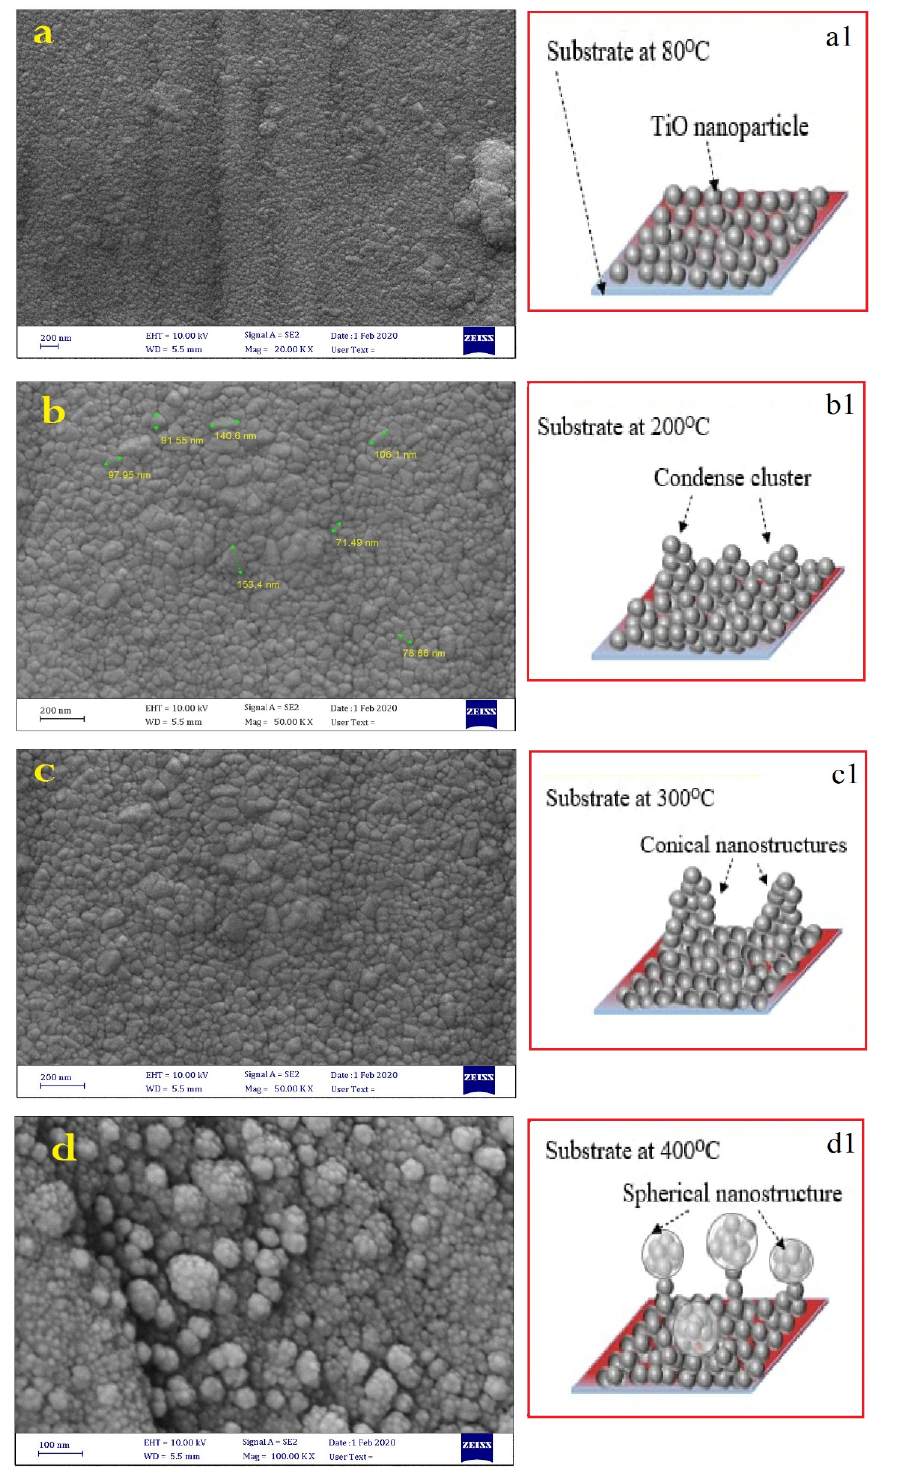
Figure 3: SEM images and schematic grain of TiO (a and a1) at 80 ∘ C (as deposited), (b and b1) at 200 ∘ C, (c and c1) at 300 ∘ C and (d and d1) at 400 ∘